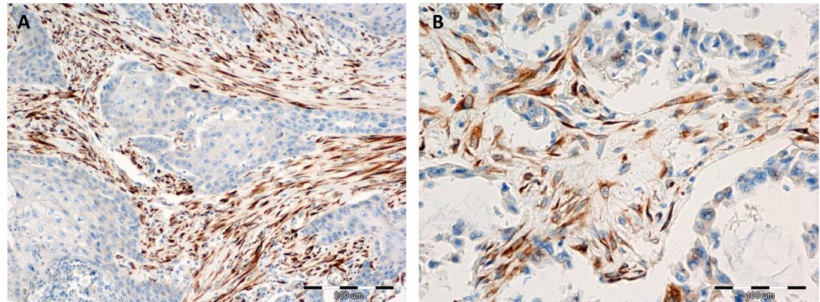
Figure 2. Positive immunohistochemical reactions (IHC—brown colour) indicating irisin expression in NSCLC stromal cells which are morphologically similar to fibroblasts, magnification × 200 ( A ), × 400 ( B ). The expression of irisin in both types of cells (cancer cells and stromal cells) was also compared in di ff erent subtypes of NSCLC: AC and SCC. The results obtained indicate a significant di ff erence in the levels of irisin expression in cancer cells of SCC compared to the AC subtype (Mann-Whitney U, p < 0.0001) (Figure 3D).